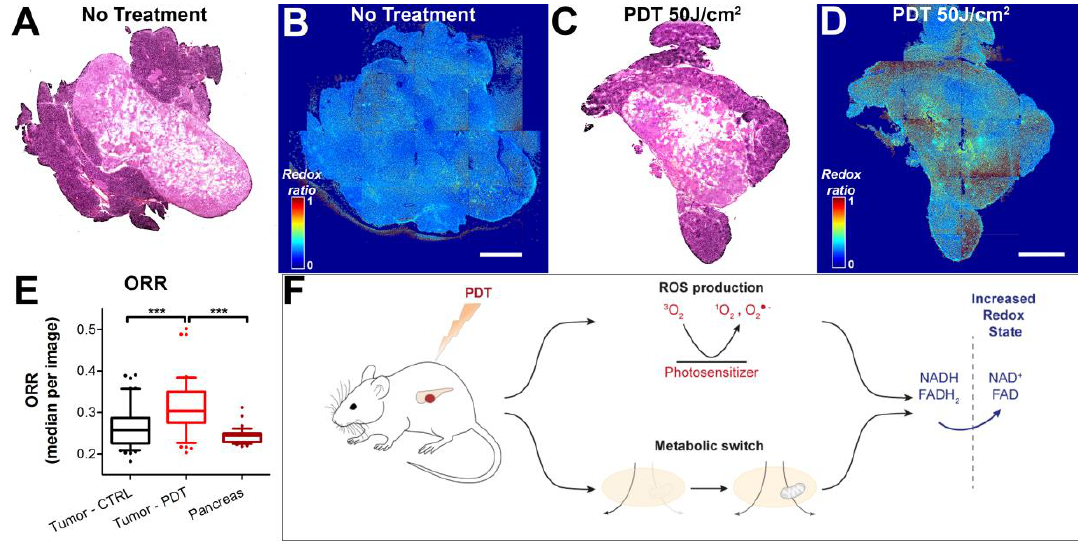
Figure 5. Redox imaging on ex vivo tissue slices of orthotopic MIA PaCa-2 tumors extracted four days post-PDT demonstrates an ORR increase following PDT. Scalebar = 1 mm. Tissue slices of orthotopically implanted MIA PaCa-2 tumors were stained with hematoxylin and eosin (H&E). Representative samples of the no treatment control group ( A ) and the PDT-treated group ( C ) are represented. Stitched redox ratio heatmaps of adjacent tumor slices are represented in ( B ) and ( D ) for the untreated tumor and the PDT-treated tumor, respectively. ( E ) Quantification of the ORR is shown in the box-whisker plots, in which the median, 25th and 75th percentiles, and 90% confidence interval of the median redox ratio per image are plotted. Data pertaining to the untreated tumor tissue are depicted in black ( N = 3 tumors, 51 images), whereas data pertaining to the PDT-treated tumor tissue are represented in red ( N = 3 tumors, 49 images). ( F ) Schematic representation of the potential origin of the redox perturbations. *** p ≤ 0.005.